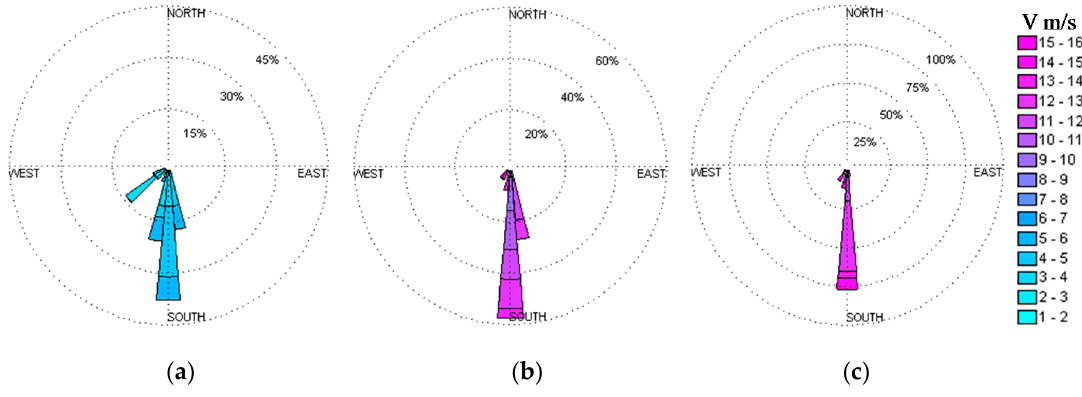
Figure 4. P2 wind roses for ( a ) NUIG measured wind, and HR modeled winds at ( b ) C1 and ( c ) A2.